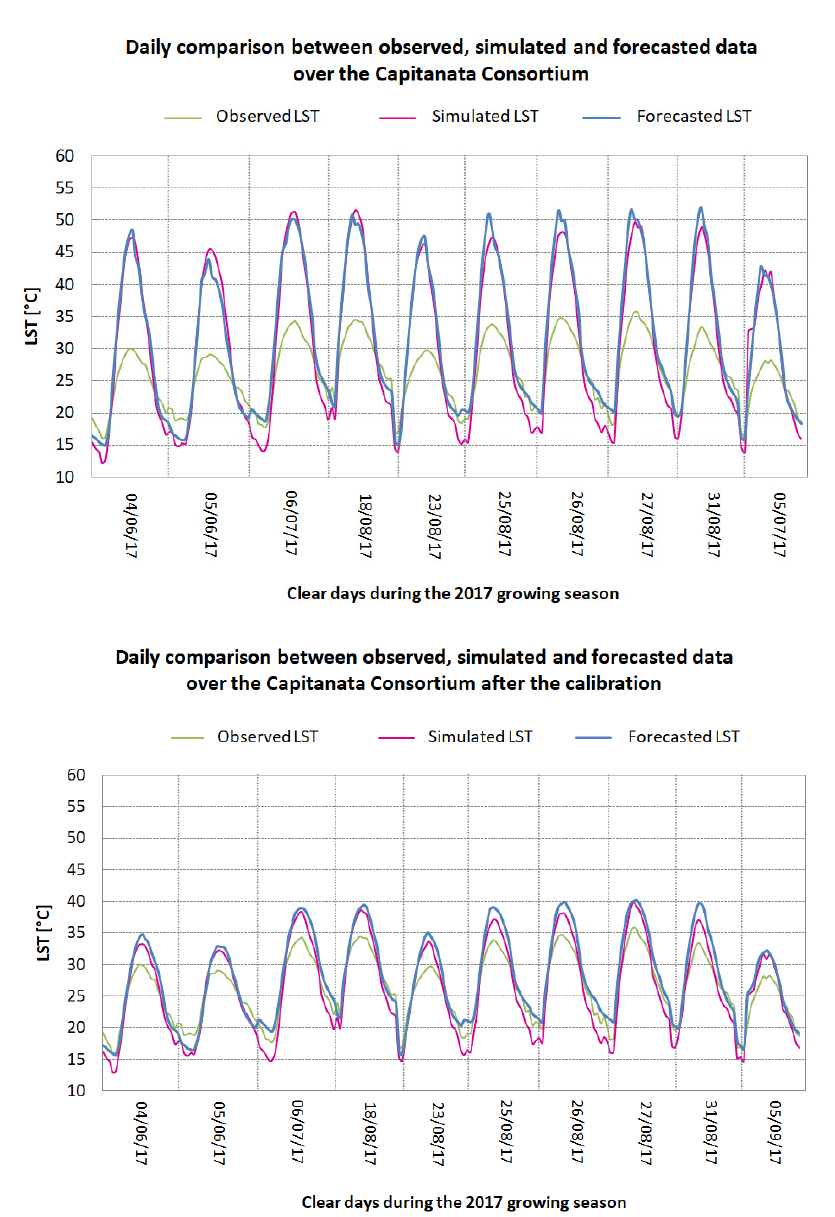
Figure 8. Comparison between observed, simulated and forecasted data over the Capitanata consortium for ten non-consecutive days during the 2017 growing season before ( top ) and after ( bottom ) the calibration.